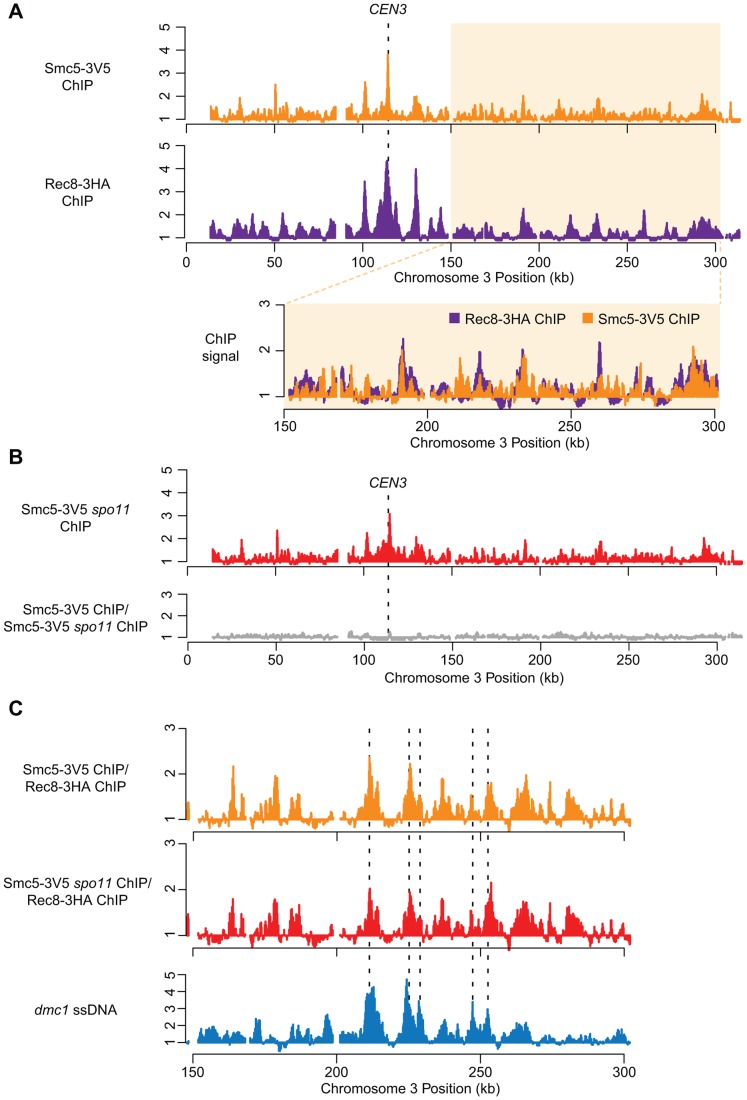
Smc5 associates with cohesin binding sites, centromeres, and DSBs.(A) DNA binding profiles for Smc5-3V5 (orange, H6671) and Rec8-3HA (purple, H4471, [65]) plotted for Chromosome III. Lower panel shows overlay of the right arm (150–300 kb) of Chromosome III. (B) DNA binding profiles for Smc5-3V5 in a spo11Δ strain (top panel, H6674) and the normalized DNA binding of Smc5-3V5 in spo11Δ strain versus Smc5-3V5 in the SPO11 strain from (A) on Chromosome III. (C) The binding profile of Smc5-3V5 (orange) was normalized to Rec8-3HA binding using the data shown in (A) to reveal weaker, non-core binding regions. DSB sites mapped by ssDNA enrichment in the dmc1Δ mutant are indicated below (blue, H118, [100]). All ChIP experiments were carried out at 3 hours after transfer to SPM. Spindles reached their max. peak at 4 hours.